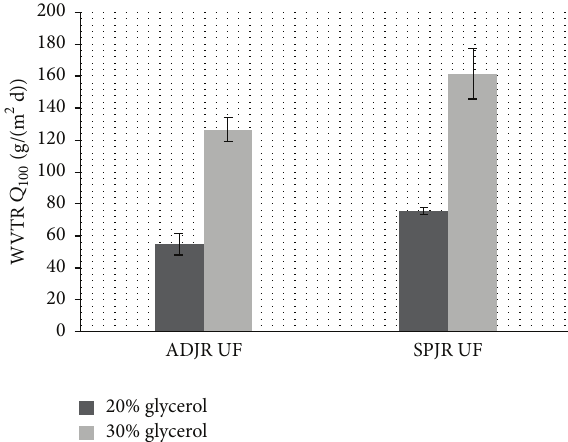
Figure 1: WVTR 50% → 0% r.h. ( Q 100 ) of ultrafiltrated (UF) ADJR and SPJR protein films with 20% and 30% (w/w) plasticizer content based on protein dry